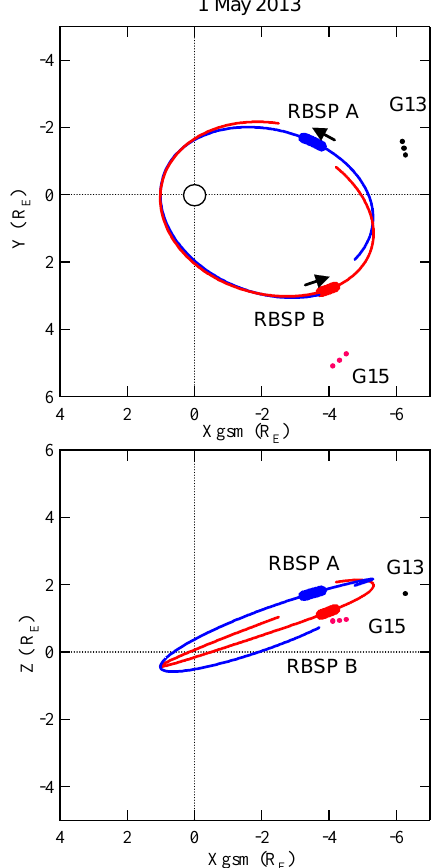
Figure 1. Orbits of Van Allen probes A (blue) and B (red) in GSM coordinates from 02:00 to 10:00UT on 1 May 2013. The thick line segments show the locations of Van Allen probes A and B from 05:40 to 06:00UT. The locations of GOES 13 and 15 from 05:40 to 06:00UT are marked by